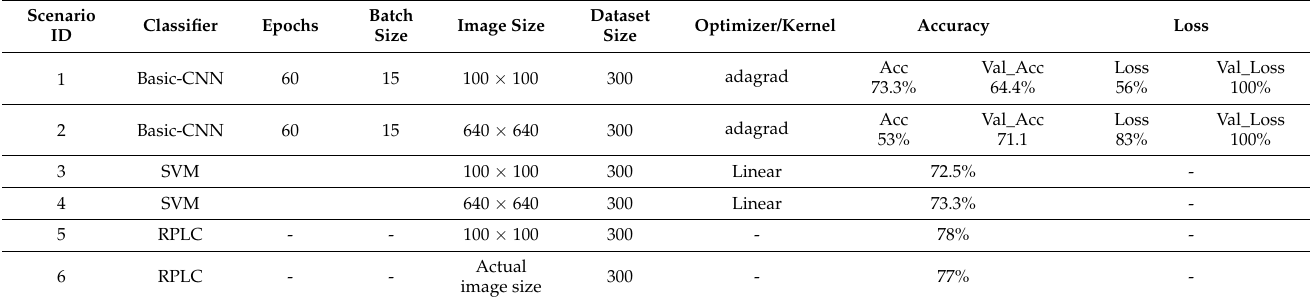
Table 2. Performance Comparison of